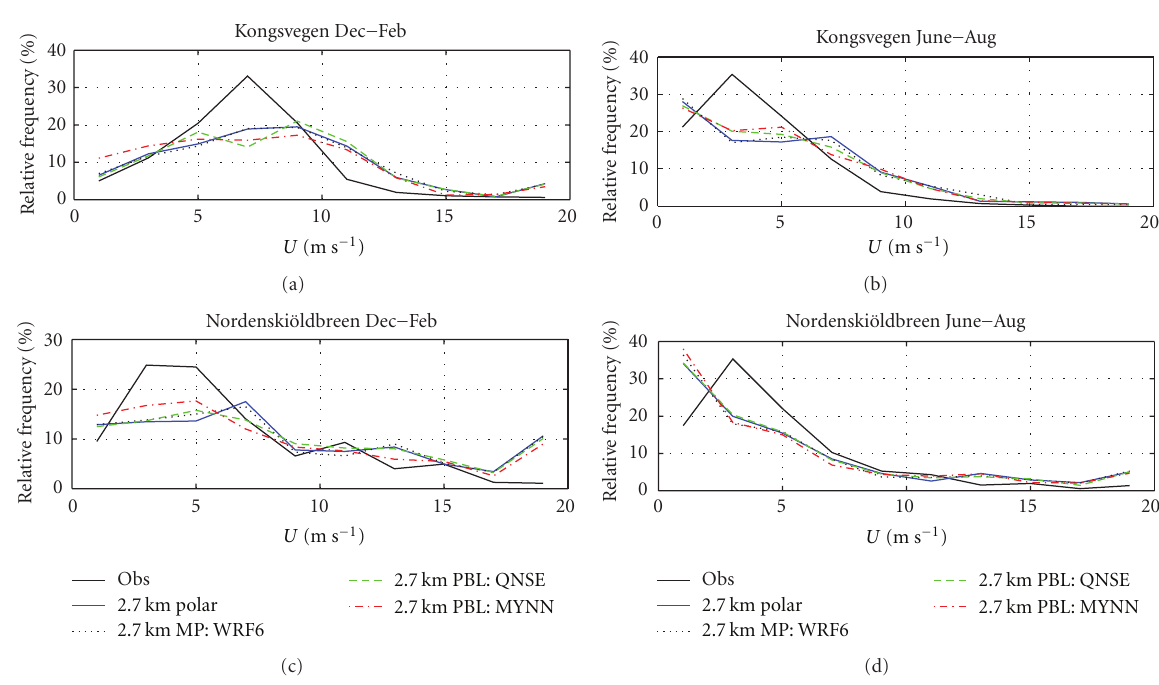
Figure 8: Frequency distribution of wind speed in Kongsvegen and